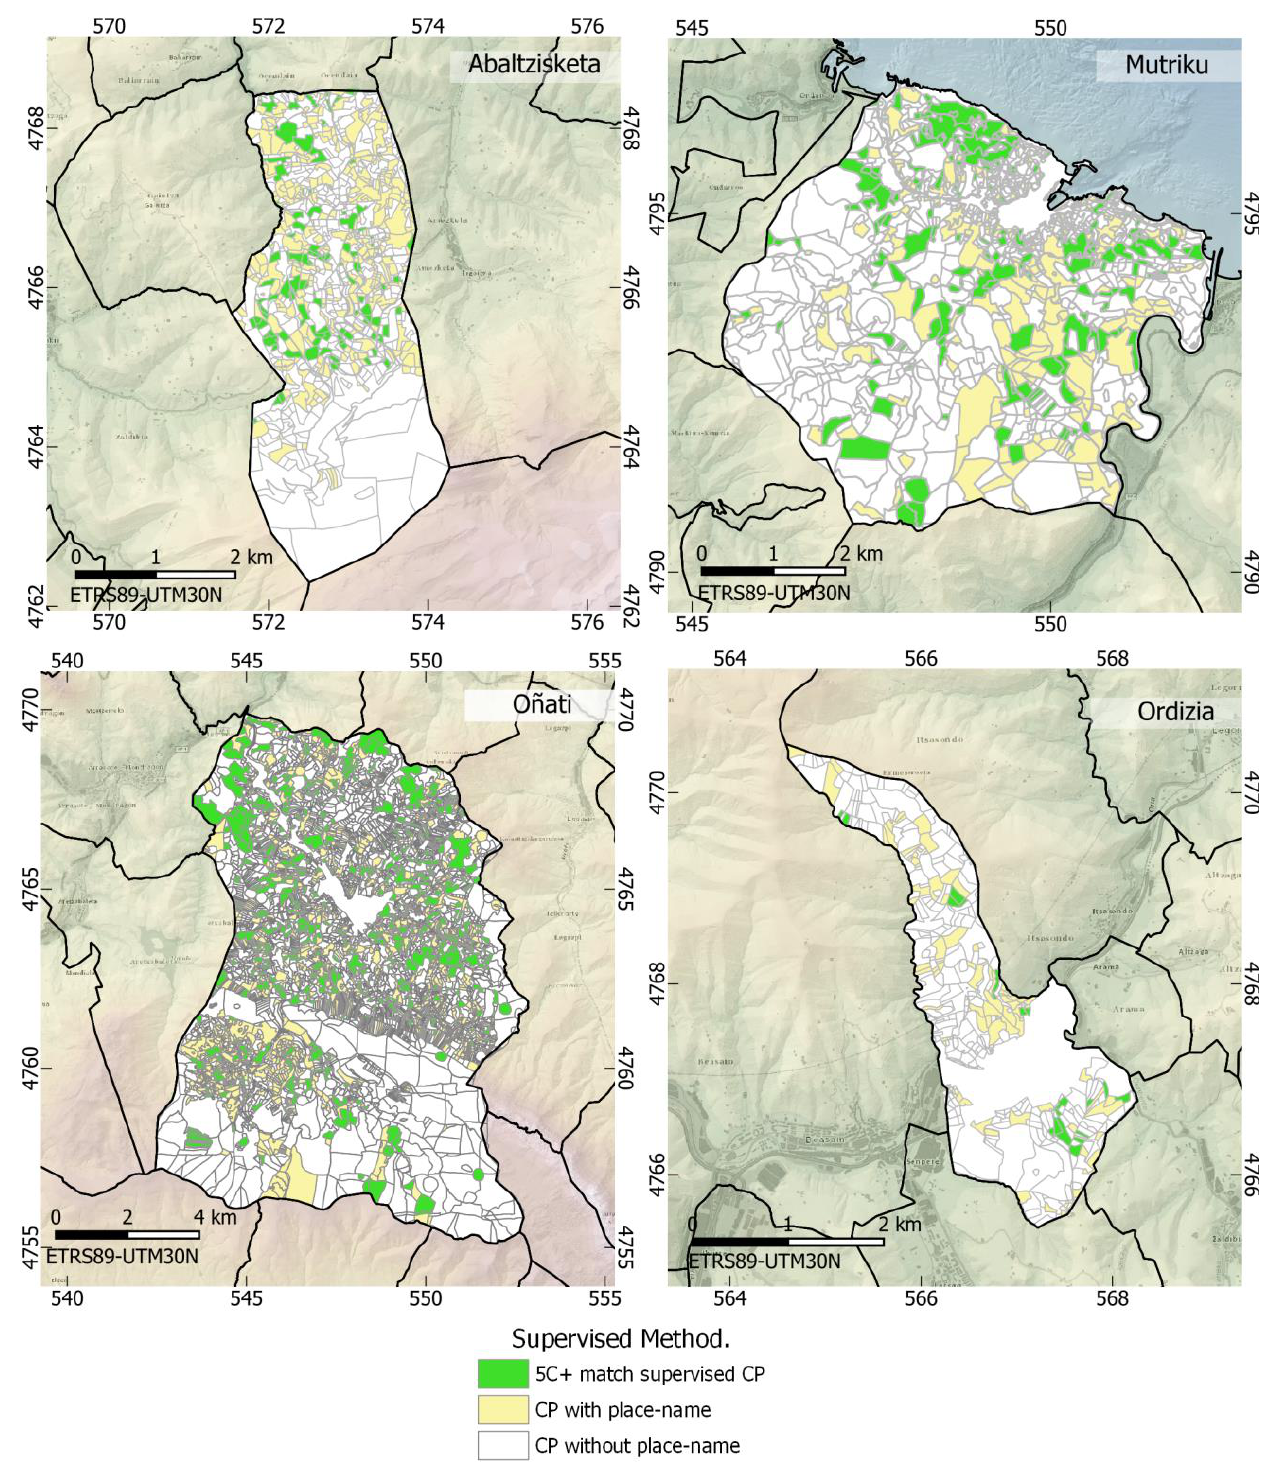
Figure 4. Cadastral parcels selected by supervision (5C+ matching). Frame coordinates in km.